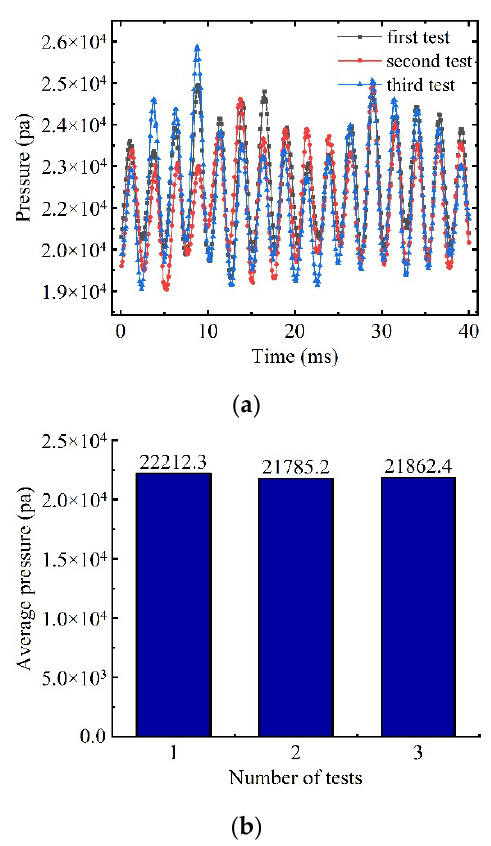
Figure 4. Three pressure pulsation tests. ( a ) Pressure pulsation curves at three tests; ( b ) comparison of average pressure at three tests.